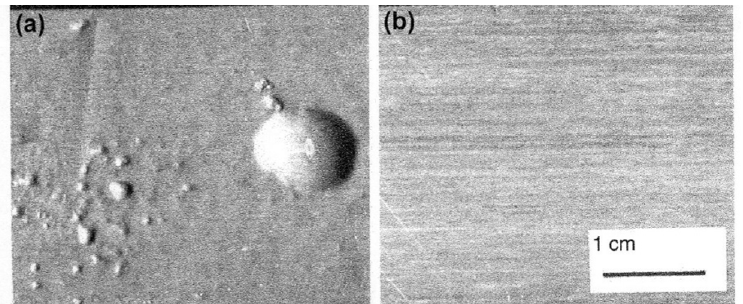
Figure 14. Surfaces of stretched sheet of 7475 (Al–Zn-Mg-Cu) alloy heated to 515 °C ( a ) in air; ( b ) in air containing some NaBF4 [39].